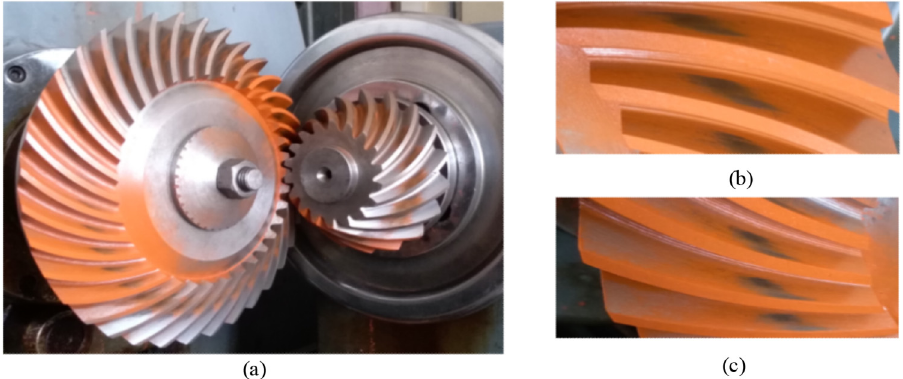
Fig. 16. Rolling test and results. (a) Rolling test. (b) Convex side of gear. (c) Concave side